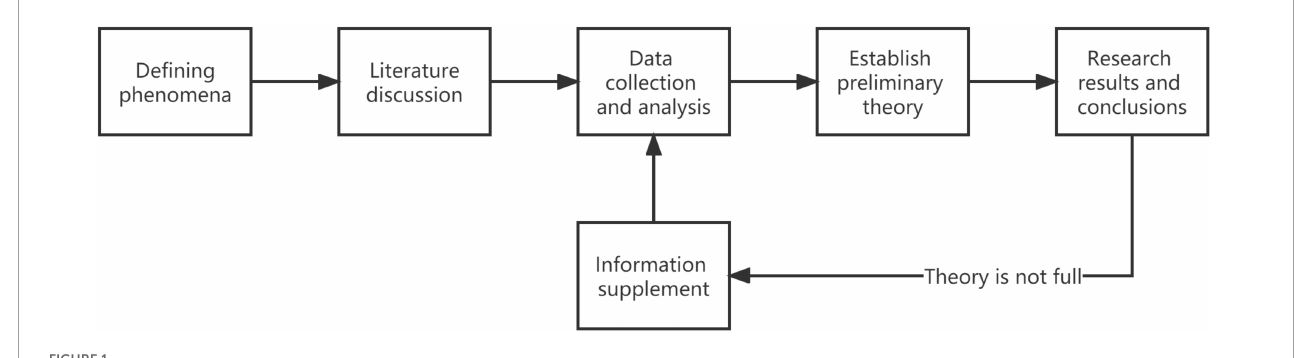
FIGURE1 Flow model of grounded theory